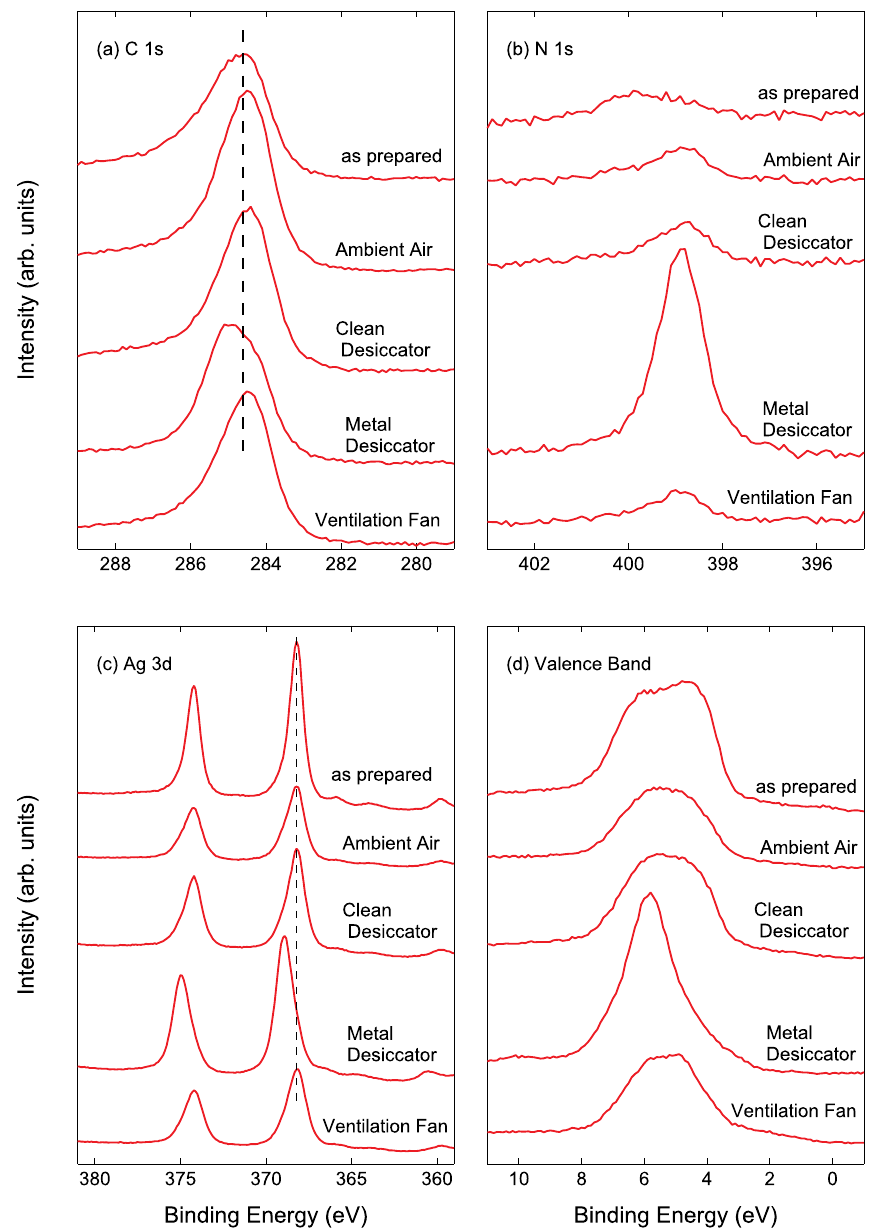
Figure 6. X-ray photoelectron spectroscopy (XPS) ( a ) C 1s, ( b ) N 1s, ( c ) Ag 3d and ( d ) valence band spectra of as-prepared Ag/HOPG sample, sample stored in ambient air, inside the clean desiccator, inside the metal desiccator and near the ventilation fan for 14 days.